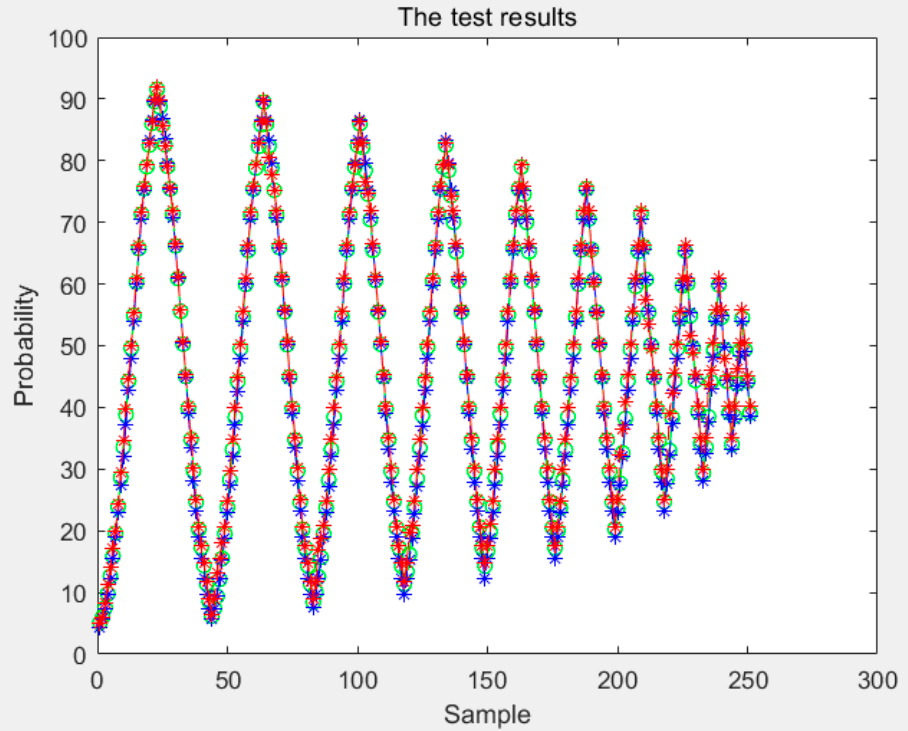
Figure 18. Test results of the second kind sensor for the sparse data.